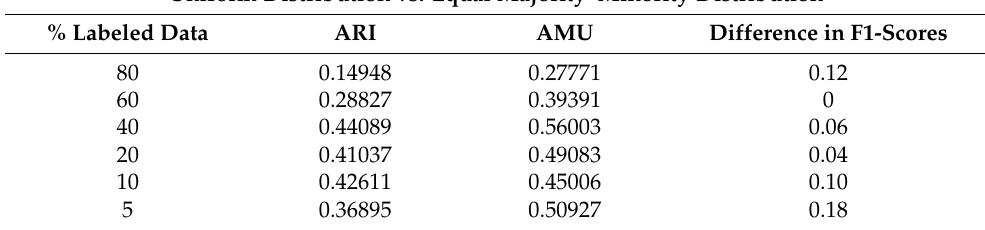
Table 13. ARI, AMU and difference in F1-scores for uniform distribution vs. equal majority– minority distribution.